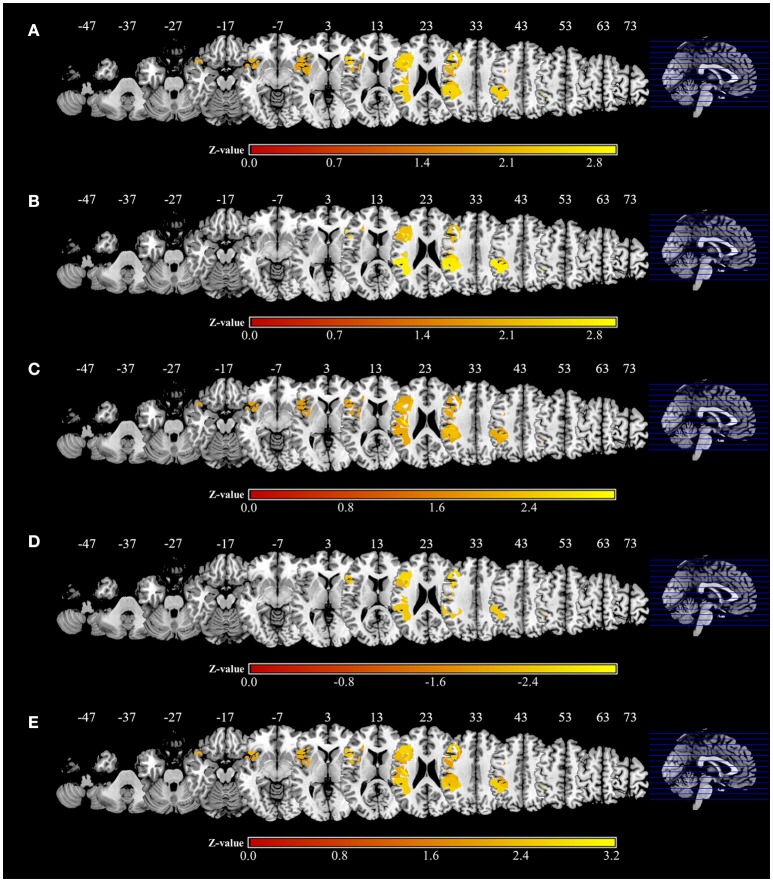
Voxel-based lesion-symptom mapping analysis. Color shades indicate z-scores (z = z-score). Axial slices with the Montreal Neurological Institute z coordinates from −47 to +73 are shown. Lesions significantly related to each factor are displayed in yellow. (A) Voxel-based lesion symptom mapping (VLSM) for the severity of apraxia (AST score). The results are shown at a false discovery rate (FDR)-corrected threshold of p < 0.05, z > 1.77. (B) VLSM for imitation deficits. FDR-corrected threshold of p < 0.05, z > 1.97. (C) VLSM for gesture deficits. FDR-corrected threshold of p < 0.05, z > 1.85. (D) VLSM for the delay detection threshold (DDT) for the detection of delayed visual feedback during active movements. FDR-corrected threshold of p < 0.05, z < −2.12. (E) VLSM for the steepness of the probability curve for the detection of delayed visual feedback during active movements. FDR-corrected threshold of p < 0.05, z > 1.82.